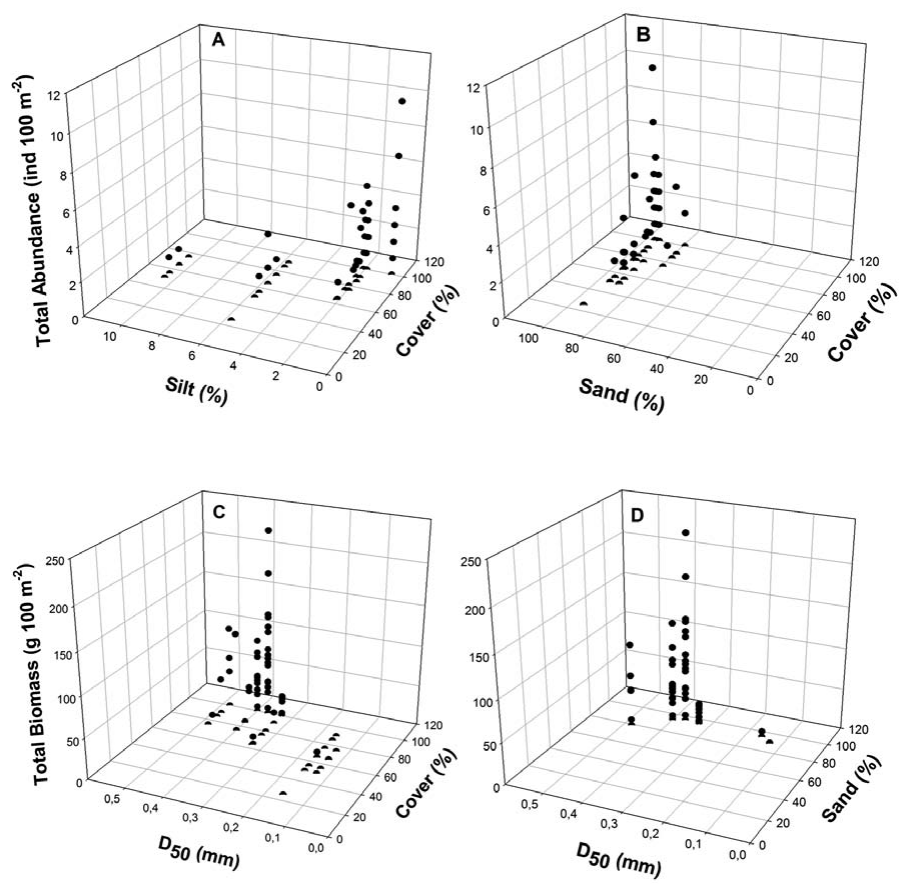
Fig. 6. – Relationships between total abundance (A-B) and biomass (C-D) of the pearly razorfish, Xyrichtys novacula , recorded through SNs, and the structural elements of the